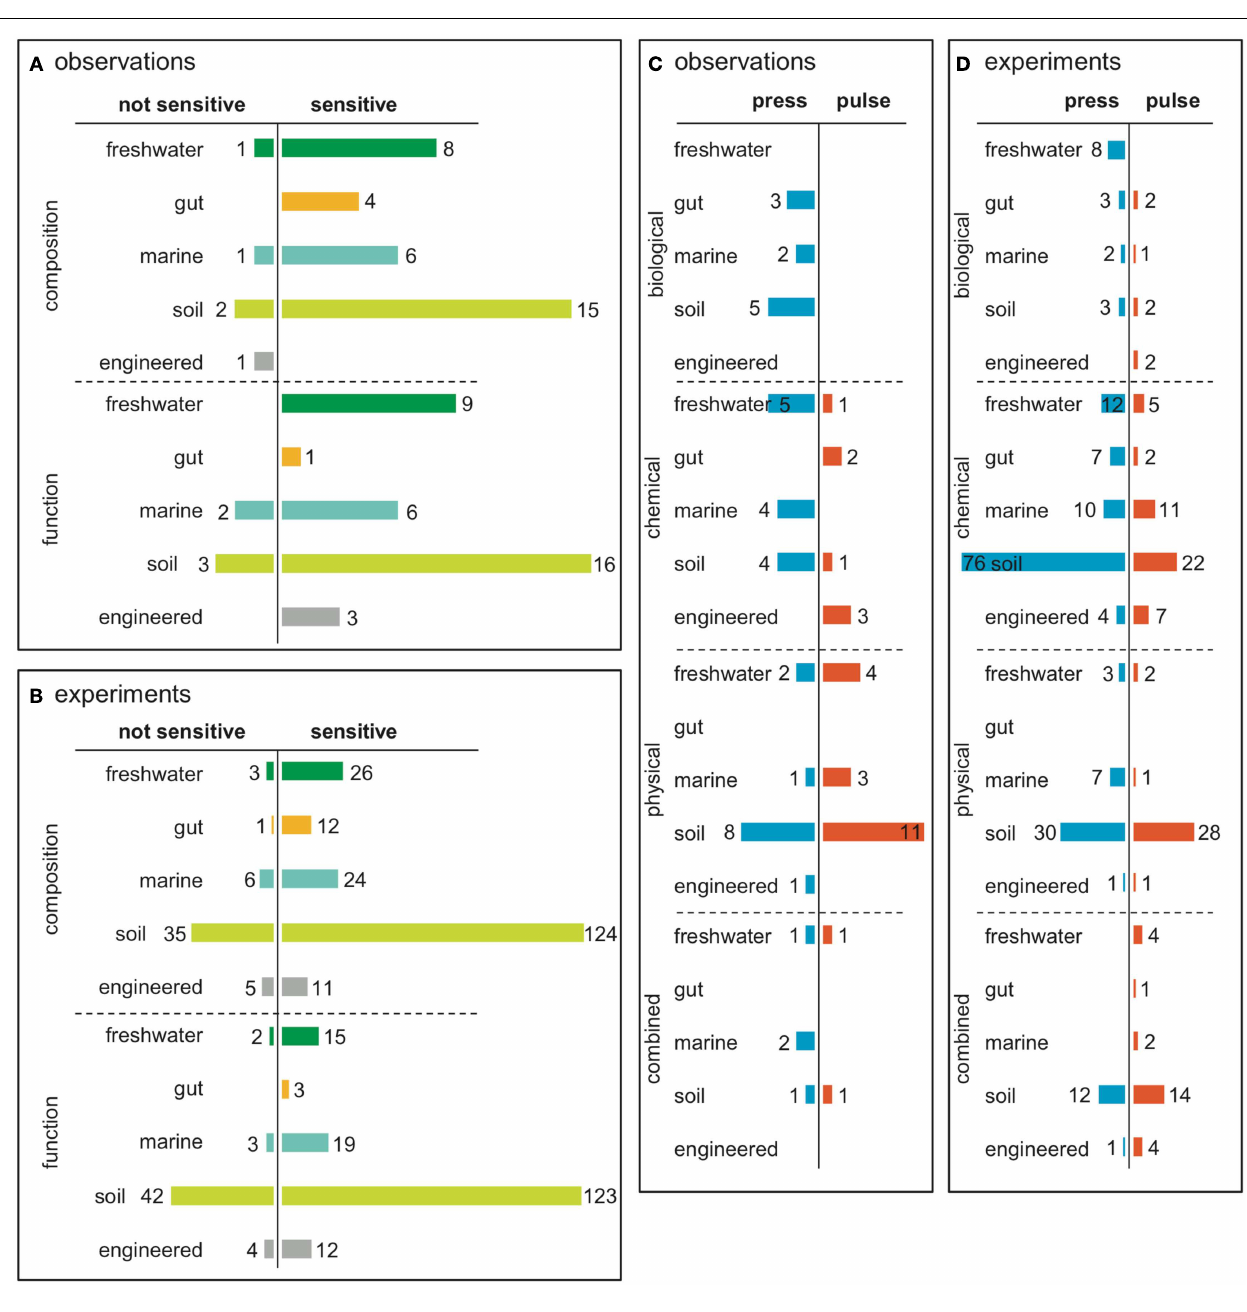
the sensitivity of microbial communities by observations and experiments, and (C,D) shows the distribution of different disturbance types between press and pulse disturbance studies. Of the investigations included, 220 investigations reported press disturbances, and 148 were pulses, four did not report press or pulse (NA), and six reported combined press and pulse. Note the lack of observational studies investigating pulsed biological disturbance (e.g., blooms) and the general shortage of work on combined effects of biological, chemical, and physical